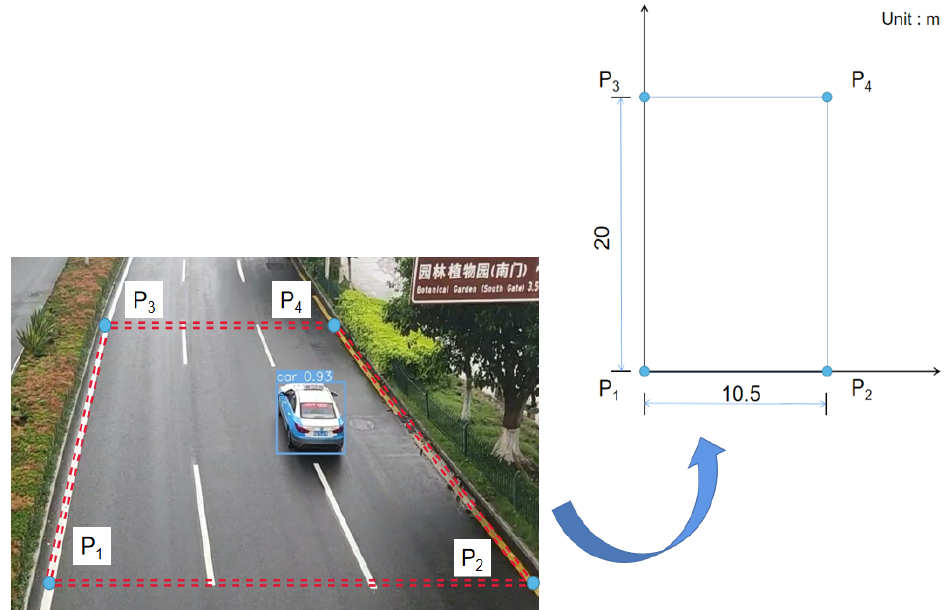
Figure 16. Reference points in the world coordinate system.